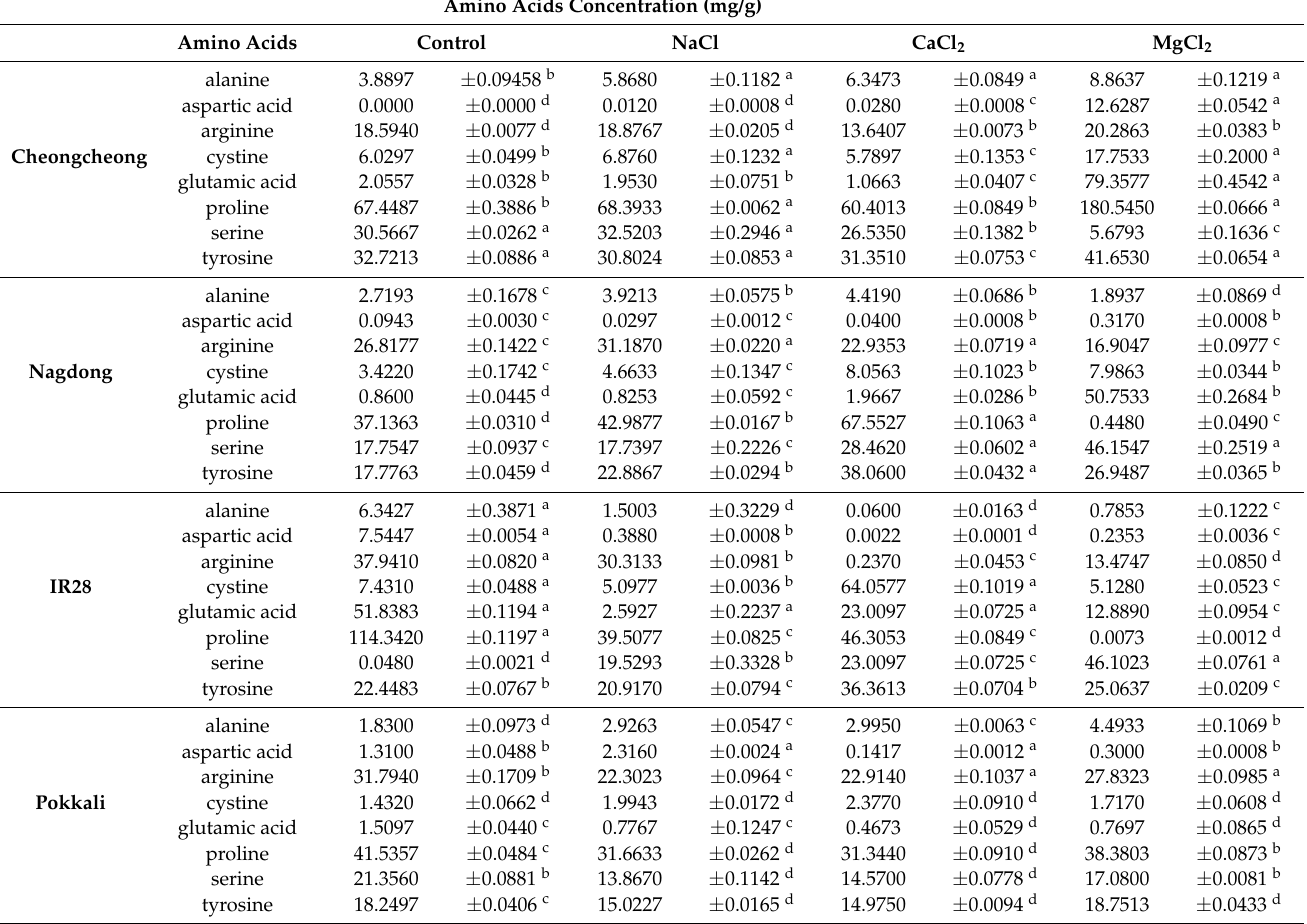
Table 2. Effects of different salt stress conditions on non-essential amino acid profiles of four types of rice seedlings. The different letters of the means ± SDs, n = 3, indicate significant variations in the contents of the amino acids. However, Duncan’s multiple range test, p 0.05, shows that the means of the identical letters are not statistically